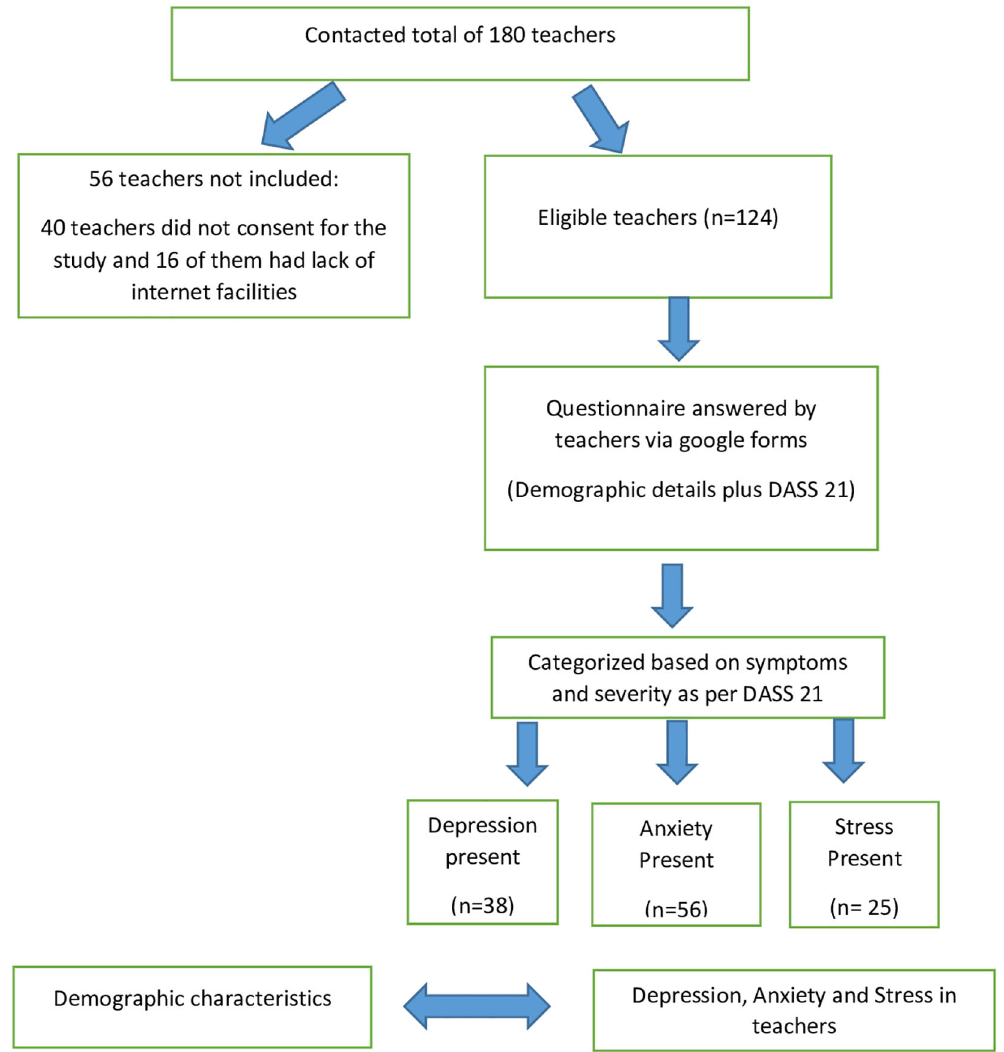
Figure 1. Study flow